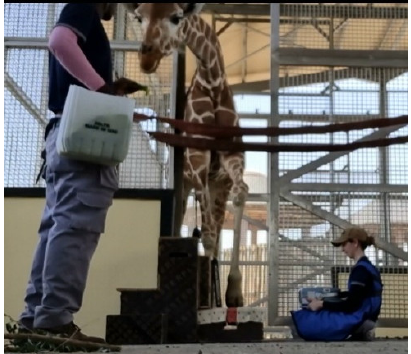
Figure 4. The direction of the radiograph beam, centred on the coronary band.